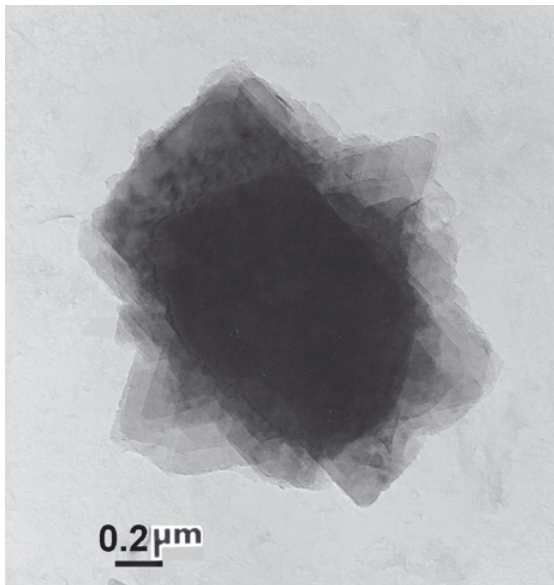
Figure 8. At four months of ageing, the nordstrandite particles present a star-shaped configuration.